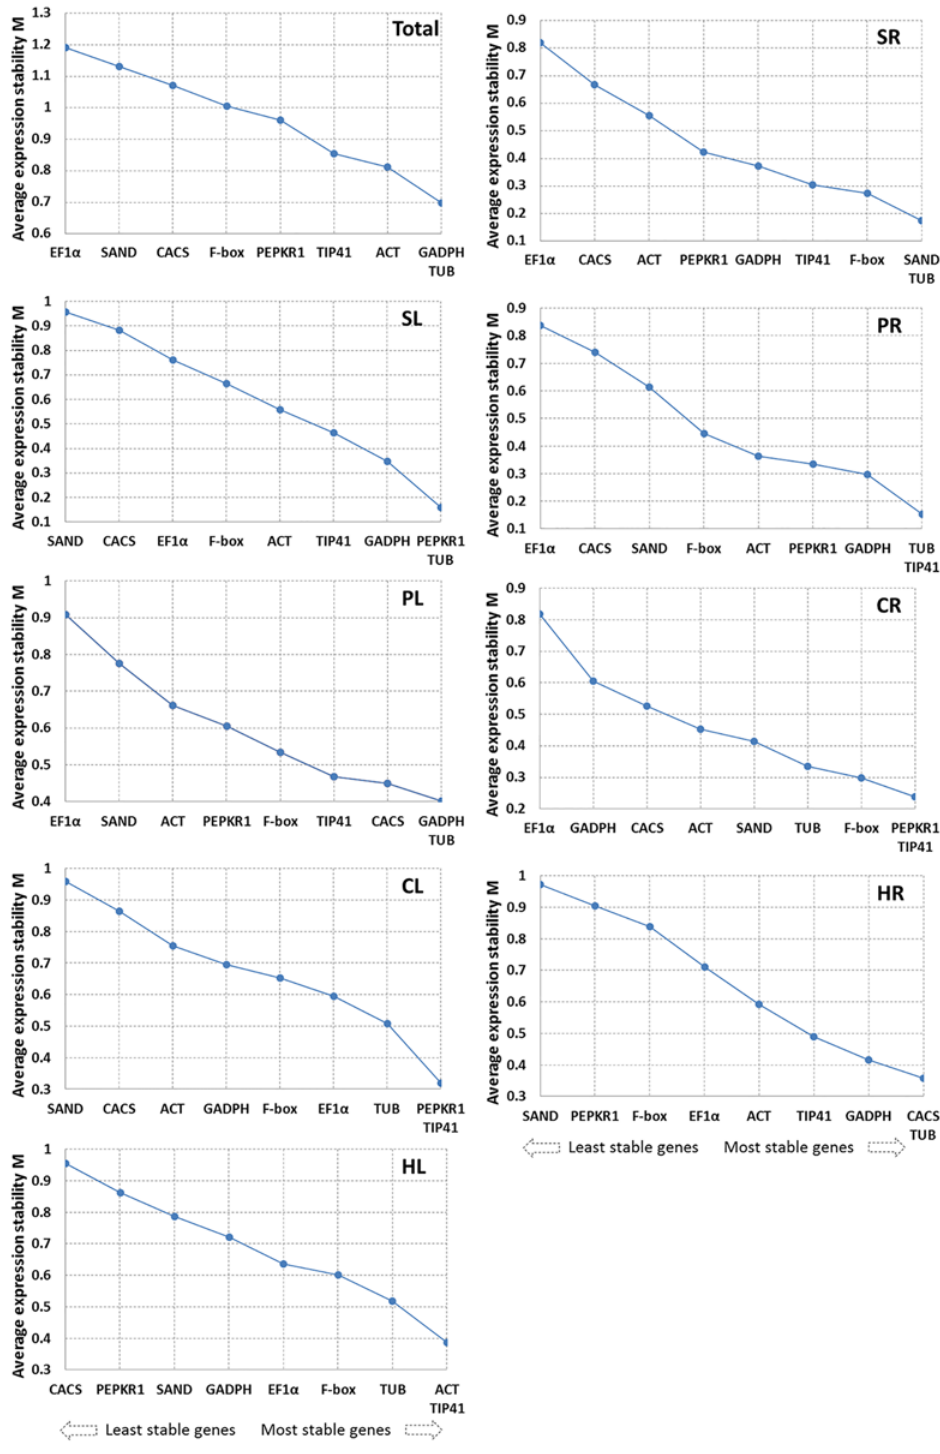
Fig 3. Gene expression stability values (M) and ranking of nine reference genes as assayed by GeNorm. The least stable genes are on the left and the most stable genes on the right. Total: all the treatments; SR and SL: salt-treated roots and leaves; PR and PL: PEG-treated roots and leaves; CR and CL: cold-treated roots and leaves; HR and HL: heat-treated roots and leaves.